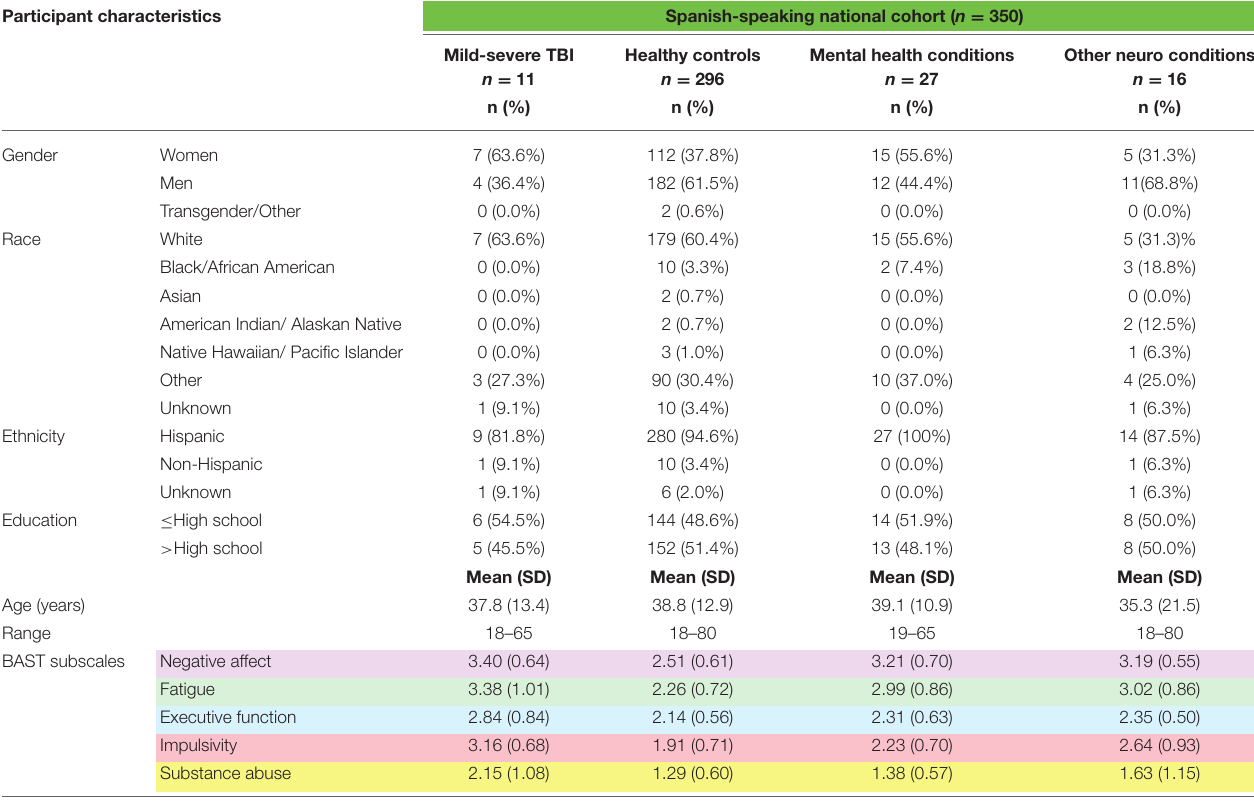
TABLE 3 | Demographics and neurobehavioral symptoms in Spanish-speaking community-dwelling adults with and without TBI. Participant characteristics